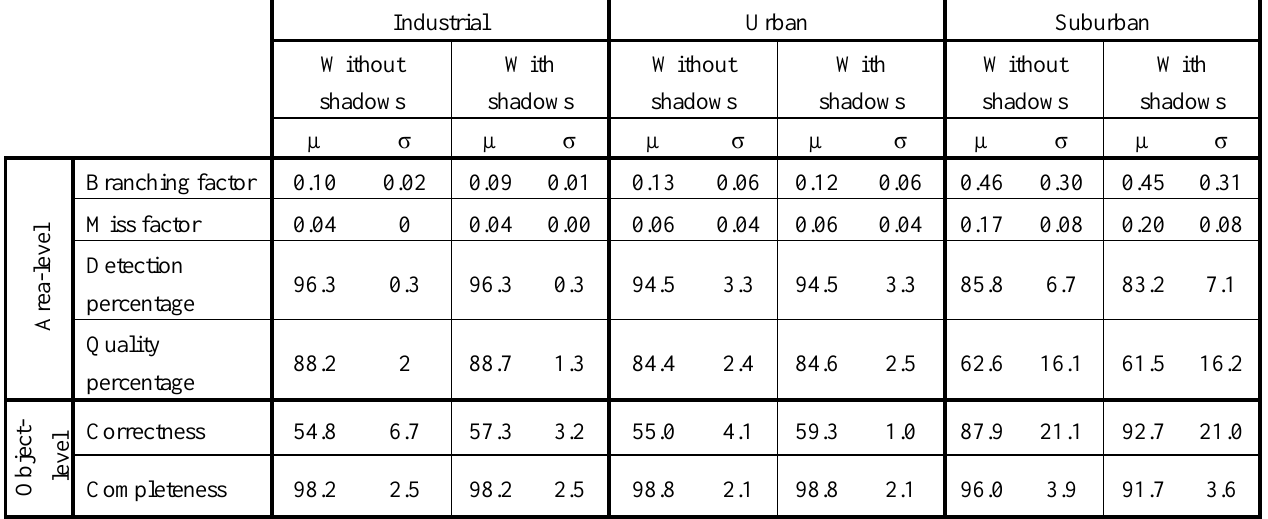
Correctness Completeness 100 0 100 0 100 Table 7. Comparison of mean (µ) and standard deviation (σ) of building detection assessment metrics with and without using shadow contextual information for the object-oriented classification approach. Industrial Urban Suburban Without With Without With Without With shadows shadows shadows shadows shadows shadows Branching